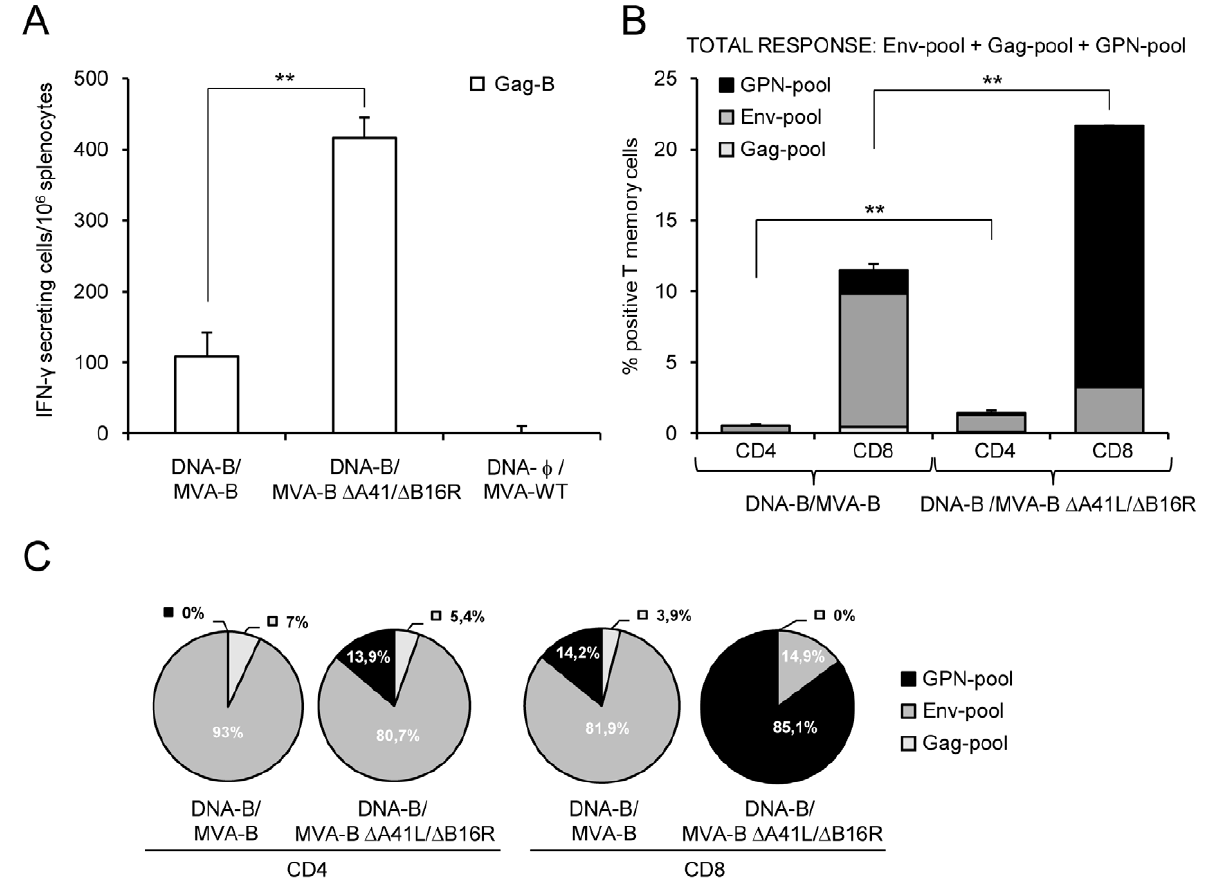
Figure 4. HIV-1-specific memory immune responses induced by MVA-B and MVA-B D A41L/ D B16R. (A) Vaccine-elicited T-cell responses of splenocytes 53 days after the last immunization with DNA-B/MVA-B or DNA-B/MVA-B D A41L/ D B16R, in a fresh IFN- c ELISPOT assay following stimulation with HIV-1 peptide Gag-B. Bars represent the total number of Gag-B-specific IFN- c secreting cells per 10 6 splenocytes in each group. Standard deviations from triplicate cultures are shown. **, represent statistically significant differences between groups, p , 0.005. A representative experiment out of two is shown. (B) Total HIV-1-specific CD4 + and CD8 + T-cell memory immune responses against HIV-1 peptide pools Env-pool, Gag- pool and GPN-pool, induced in mice 53 days after the last immunization with DNA-B/MVA-B or DNA-B/MVA-B D A41L/ D B16R, and measured by ICS. The percentage of HIV-1-specific CD4 + and CD8 + T memory cells for Env-pool, Gag-pool and GPN-pool is indicated by different color codes and the frequencies were calculated as the addition of single and double positive T cells for the secretion of IFN- c and IL-2; thus, each responding cell was counted once. The background of the unstimulated controls was subtracted in all cases, and only significant values over the background are represented. Standard deviations are shown. **, represent statistically significant differences between groups, p , 0.005. (C) The pie charts summarize the data of panel B, with each set representing the fraction of CD4 + or CD8 + T memory cells specific for Env-pool, Gag-pool and GPN-pool. A representative experiment out of two is